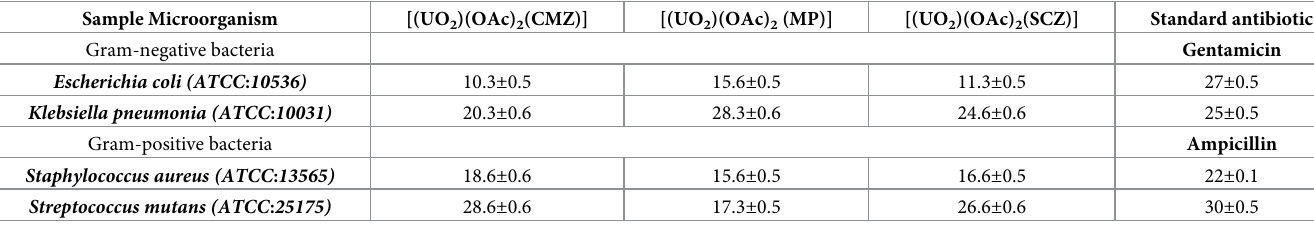
Table 6. Antibacterial activity of the synthesized uranyl complexes by agar cup method.